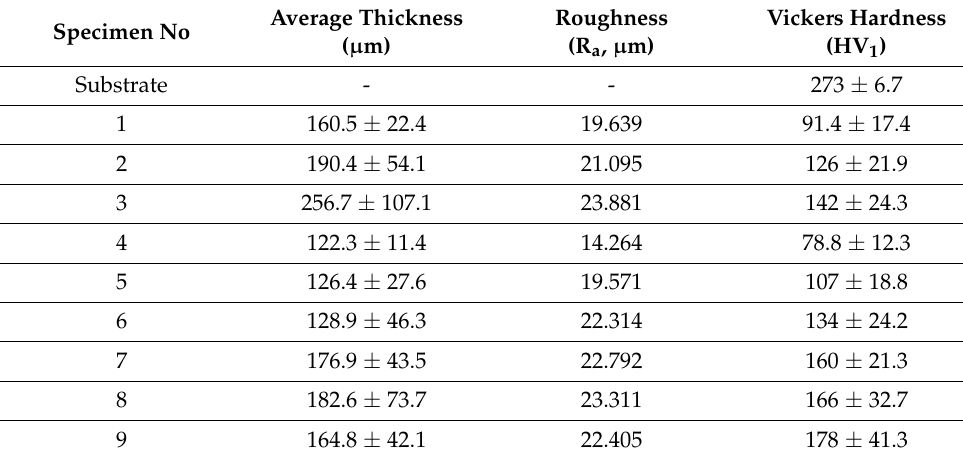
Figure 9. Cross-section SEM images of coatings number 1, 3, 4, 6, 7 and 9 at ×1500 magnification. Table 4. Average thickness, roughness, and hardness values of